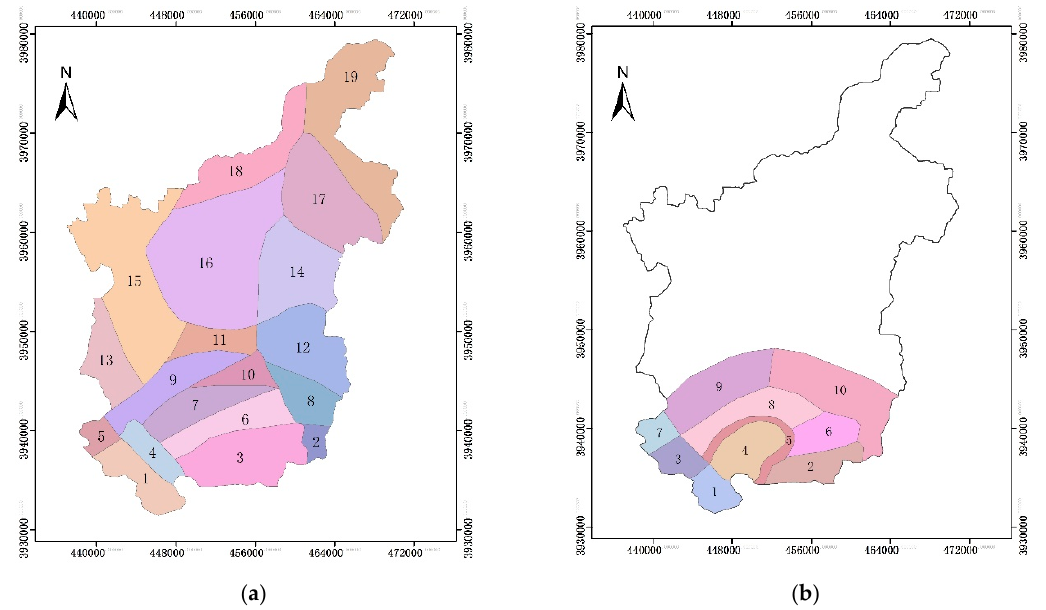
Figure 4. ( a ) The first aquifer range and boundary conditions. ( b ) The second aquifer range and boundary conditions.